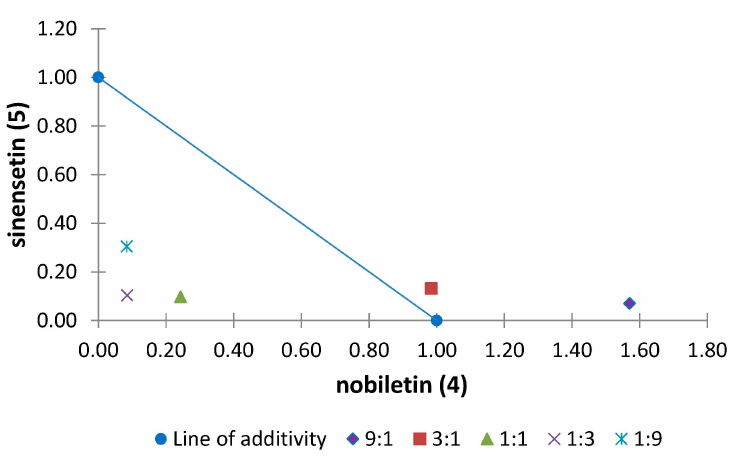
Figure 10. Normalized isobologram (ED 25 ) for the binary mixture nobiletin ( 4) /sinensetin ( 5 ) in the etiolated wheat coleoptile bioassay. (Combination ratios 9:1; 3:1; 1:1; 1:3; 1:9). The combination ratios